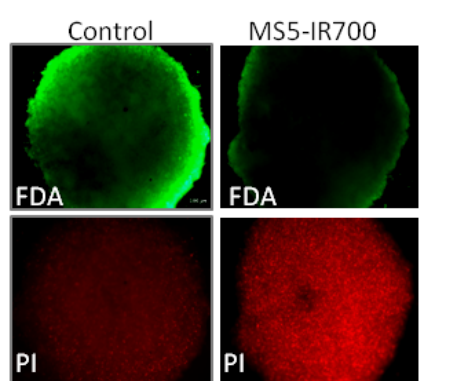
Figure 7. MS5-IR700 conjugate killed PC3 spheroids. ( A ) Spheroid around 200 μ m diameters were incubated with the conjugate 10 μ g/mL for 6 h at 37 °C and then irradiated at the light dose of 60 J/cm 2 at a power density of 17 mW/cm 2 . After overnight incubation at 37 °C, the live/dead cells were visualized by incubation with FDA and PI. ( B ) Spheroid growth after NIR irradiation. Spheroids (around 350 μ m in diameter) were incubated or not with the MS5-IR700 conjugate as in ( A ). A con- trol group received IR700 (100 nM). After NIR exposure, spheroid diameters (3–4 spheroids/group) were measured every day up to 5 days. For illustration, light images of the spheroids on days 1 and 3 post-NIR irradiation are shown ( C ). The data are representative of 4 independent experiments. * p < 0.05, ** p < 0.01, *** p < 0.001, **** p < 0.0001. 3.6. Induction of Reactive Oxygen Species after PIT Treatment The generation of reactive oxygen species (ROS) after irradiation usually contributes to the phototoxicity of PSs [3,9]. Therefore, we have investigated whether ROS production occurred during NIR-PIT using a cell-permeable fluorescent probe dichlorodihydrofluo- rescein diacetate (H 2 DCFDA). In the presence of ROS, H 2 DCFDA is oxidized and con- verted into a green fluorescent product that can be detected by flow cytometry. PC3 cells labeled with H 2 DCFDA (5 μ M) and treated with the MS5-IR700 conjugate showed an in- crease in fluorescence at 6 and 20 h post-NIR irradiation, whereas those treated with IR700 displayed baseline levels of ROS production similar to untreated or MS5-IR700- treated cells without NIR irradiation (Figure 8A,B)